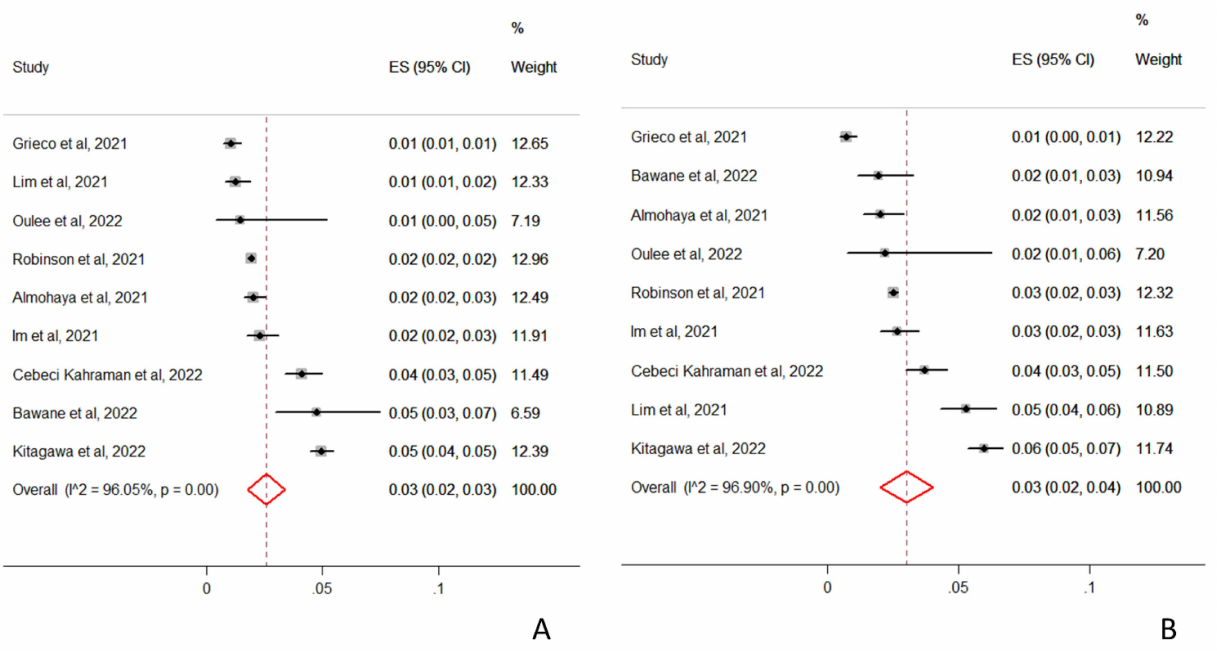
Figure 3. Forest plot and pooled estimates of the incidence of cutaneous adverse reaction to first ( A ) and second ( B ) dose of SARS-CoV-2 vaccines in 9 eligible